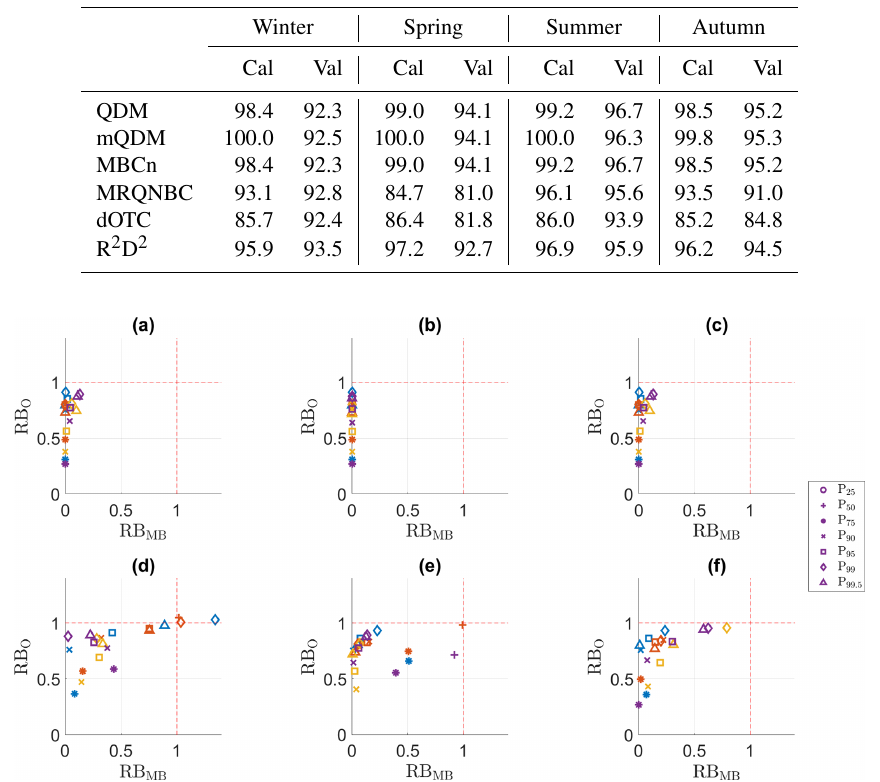
Figure 1. RB MB versus RB 0 for the precipitation indices in the calibration period. (a) QDM, (b) mQDM, (c) MBCn, (d) MRQNBC, (e) dOTC, (f) R 2 D 2 . Winter: blue, spring: ochre, summer: yellow, autumn: